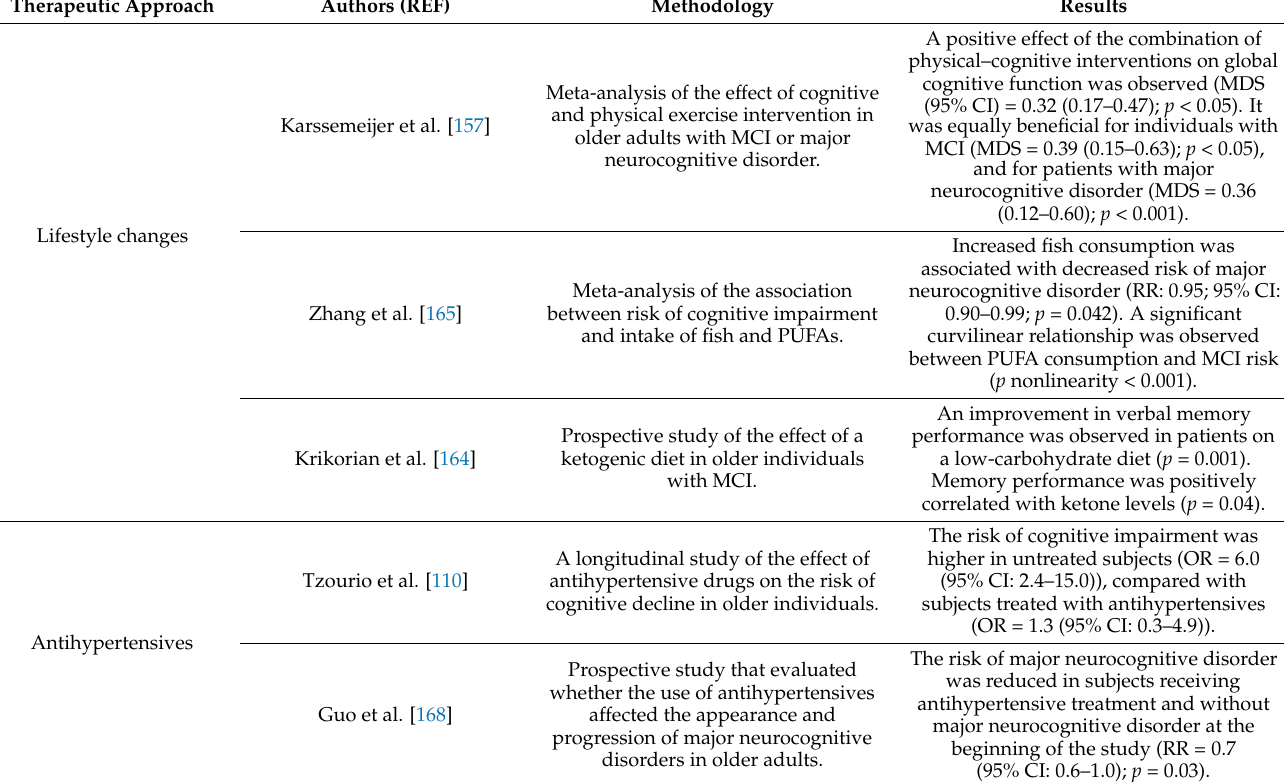
Table 2. Association between treatment of MS elements and MCI